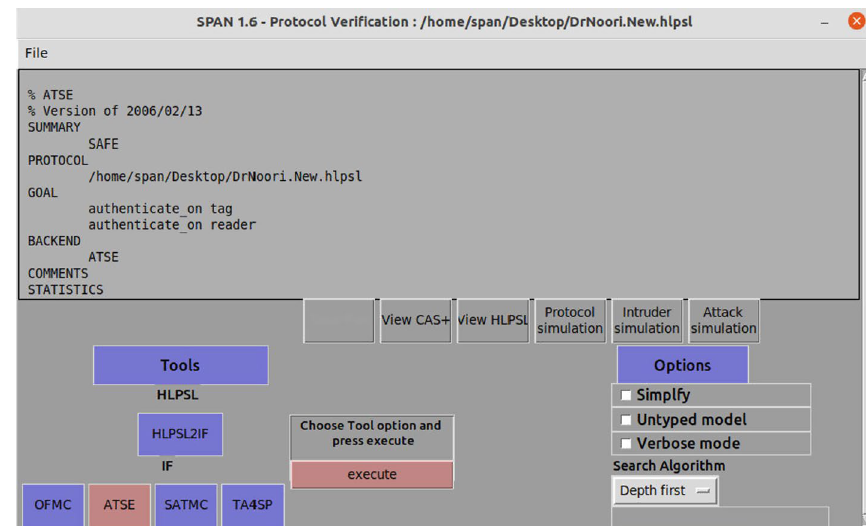
Fig. 10 Output of the proposed protocol using